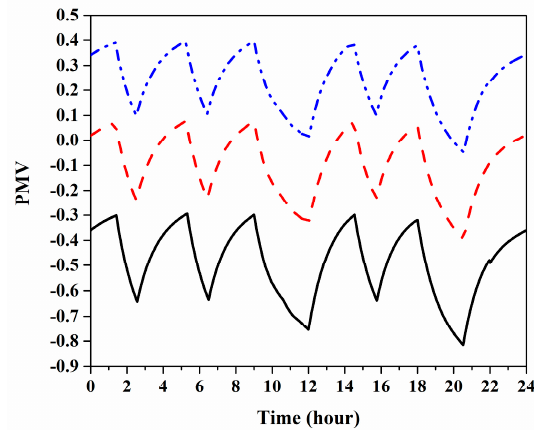
Figure 8. Comparison of PMV (—: scenario 2 A, - -: scenario 2 B, and —- -: scenario 2 C).